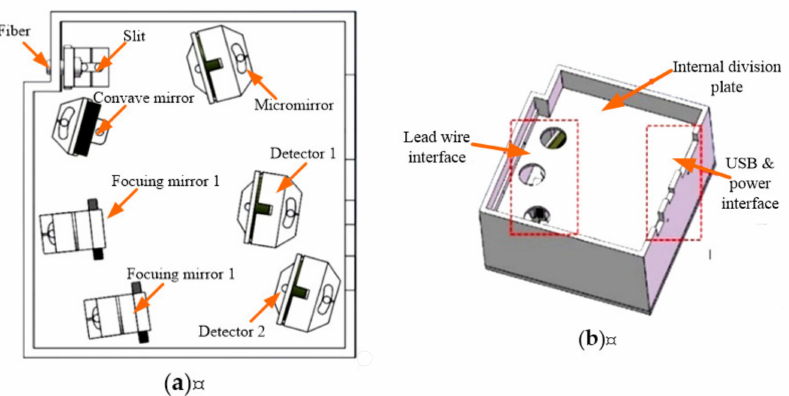
Figure 15. The layout of the designed micro-NIR spectrometer. ( a ) Internal structure layout. ( b ) Internal partition between the optical system and circuit board.